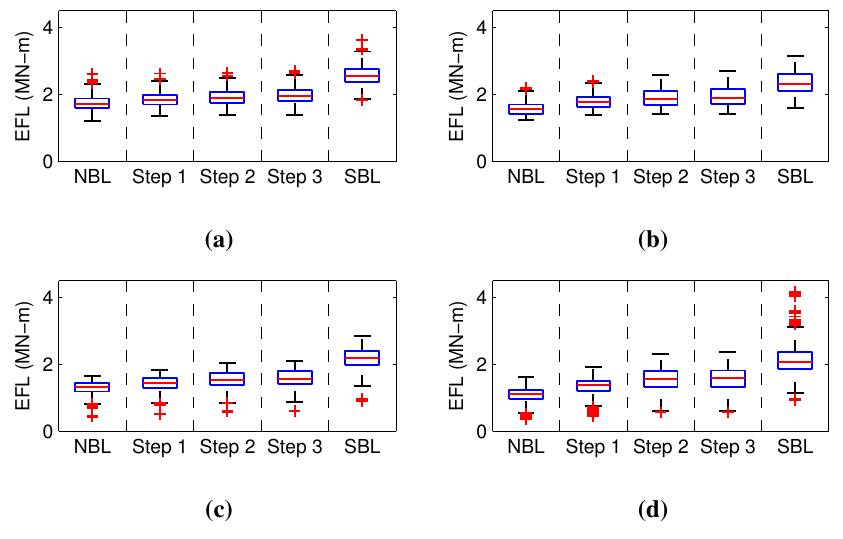
Figure 27. EFL statistics for TTYM from 2200 wind fields (SBL versus baseline NBL and < 0 modified cases). ( a ) z α